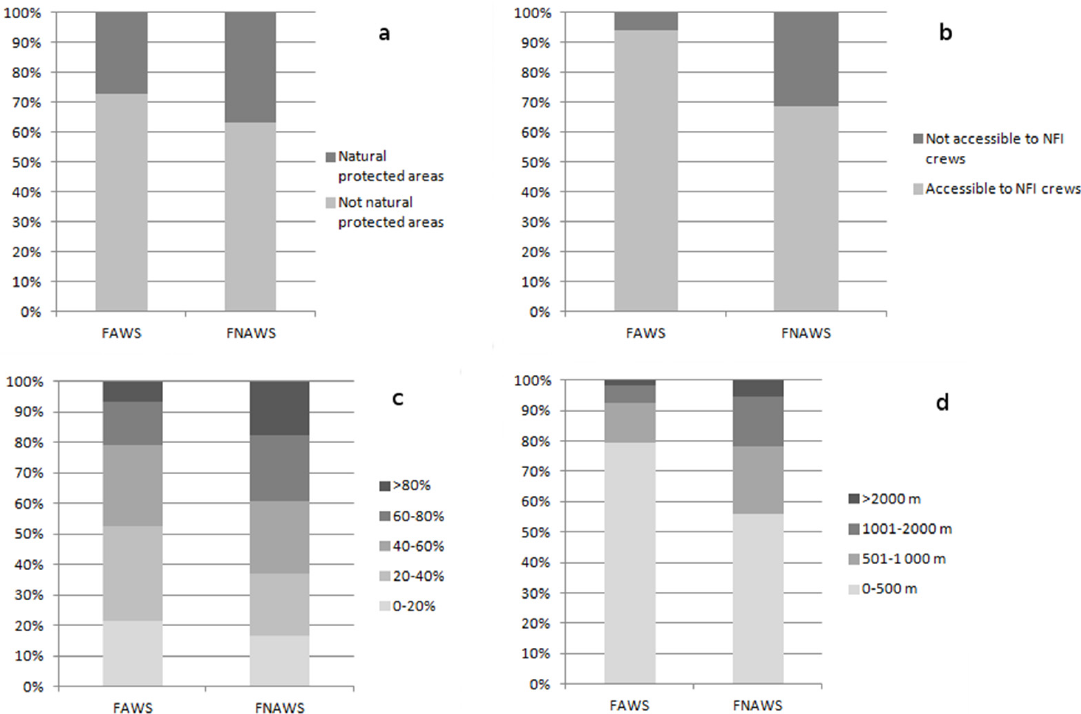
Figure 1. Distribution of forest plots by: protection status ( a ); accessibility to NFI crews ( b ); percent slope ( c ); and distance to forest roads ( d ). FAWS: forest available for wood supply; FNAWS: forest not available for wood supply.